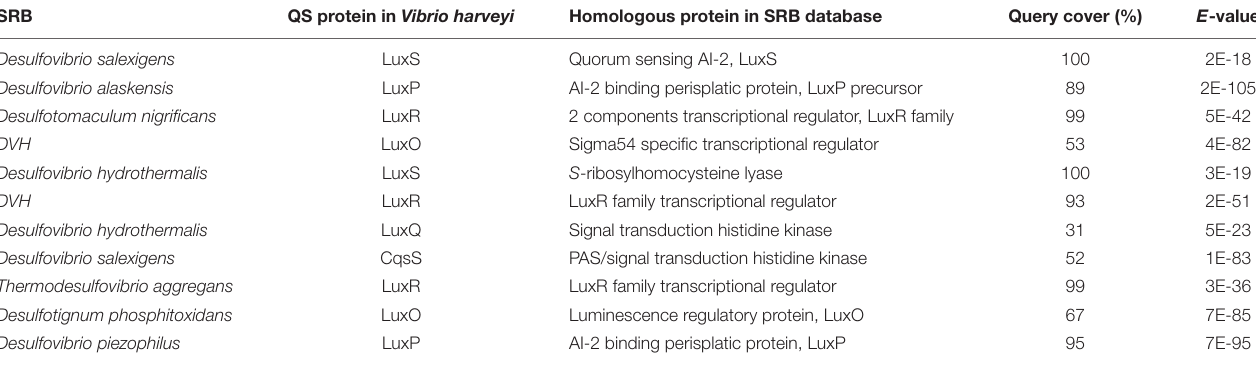
TABLE 2 | Quorum sensing (QS) protein homologs in SRB as compared to Vibrio harveyi.